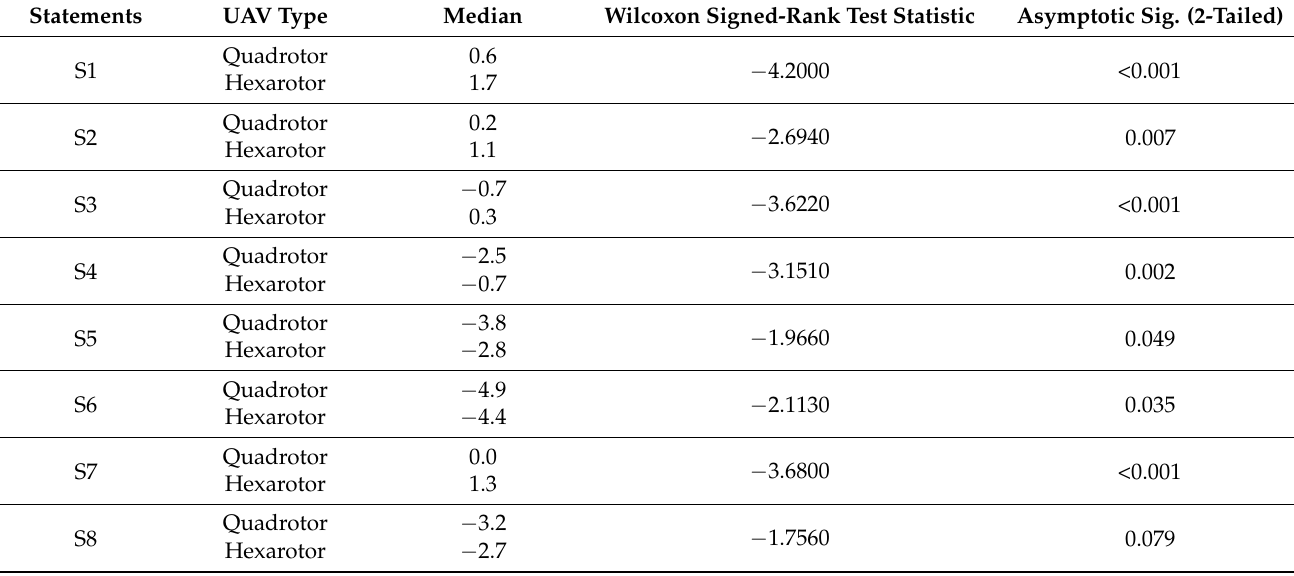
Table 6. Related samples Wilcoxon signed-rank test summary (quadrotor vs.